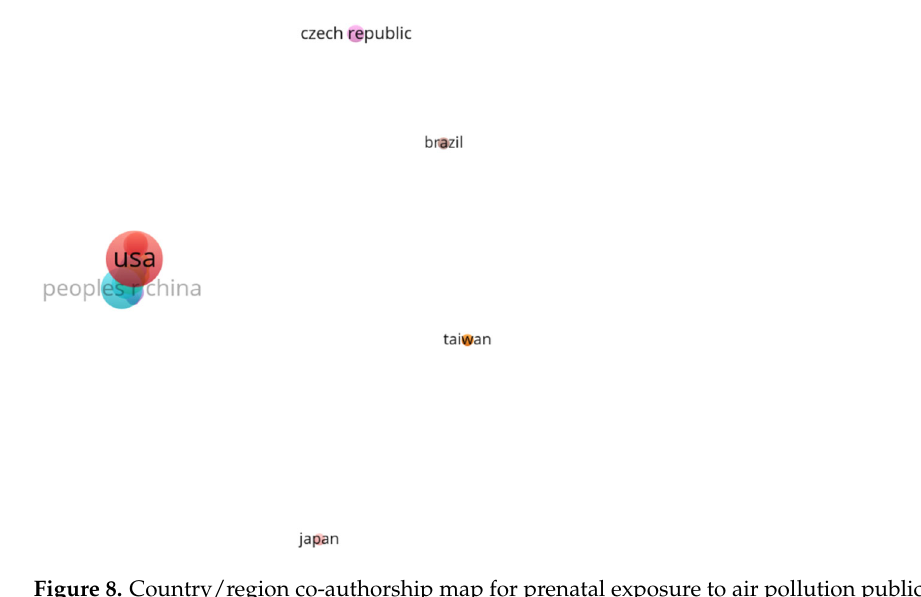
Figure 9. Expanded country/region collaboration map.